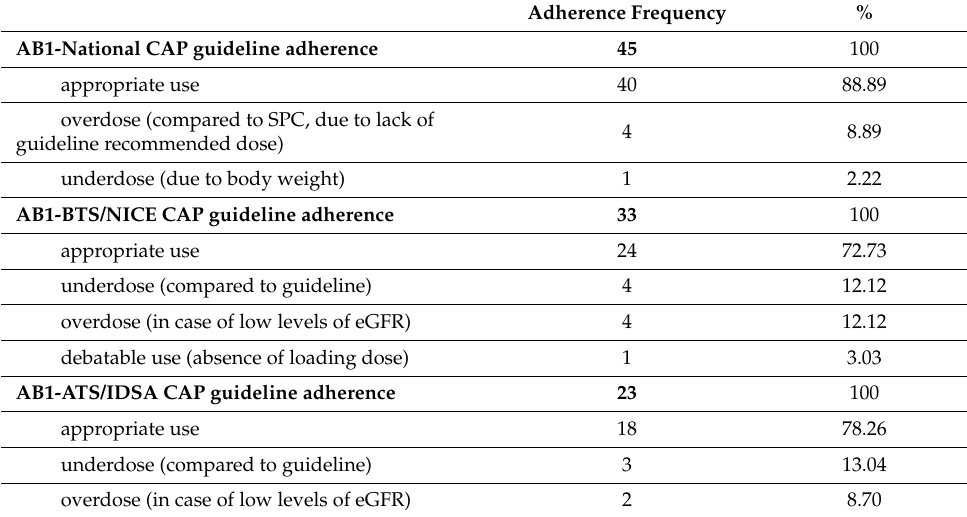
Table 4. Guideline adherence, N = 147